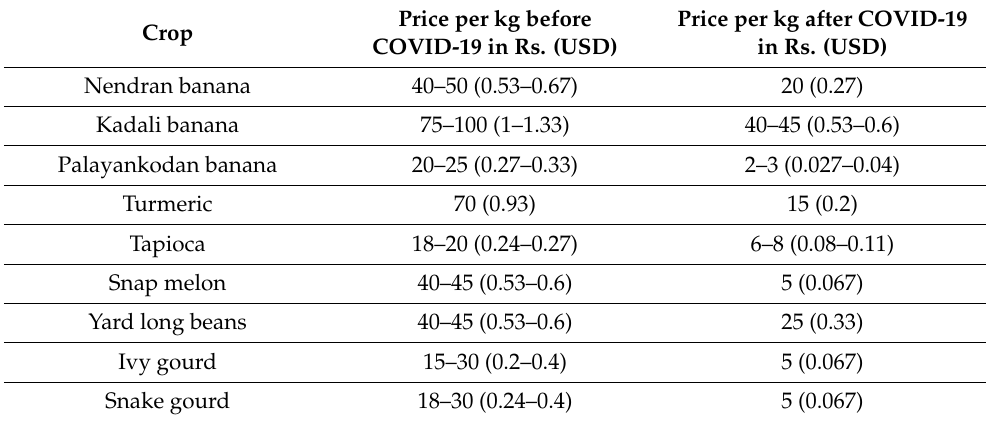
Price per kg after COVID-19 in Rs. (USD)